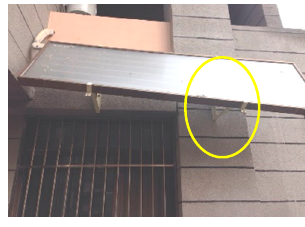
Figure 8. Common problems with wall-mounted installation.